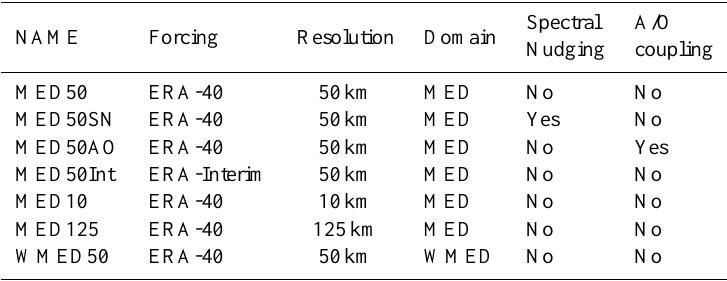
Table 1. List and characteristics of the ALADIN-Climate